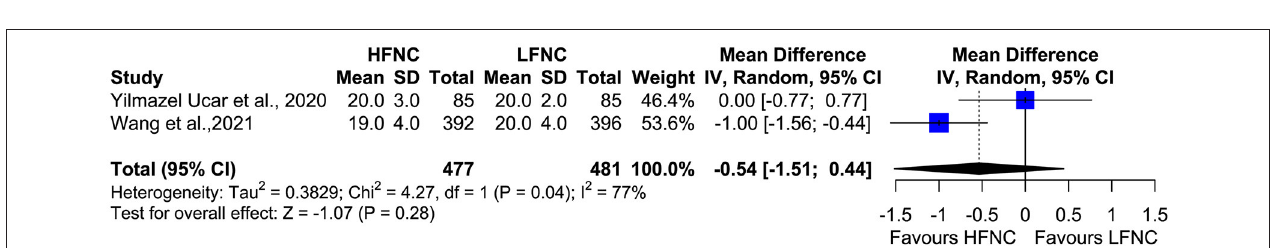
FIGURE 9 | Meta-analysis of SpO2 10min after the end of the procedure in patients receiving HFNC compared to LFNC in patients undergoing bronchoscopic procedures.